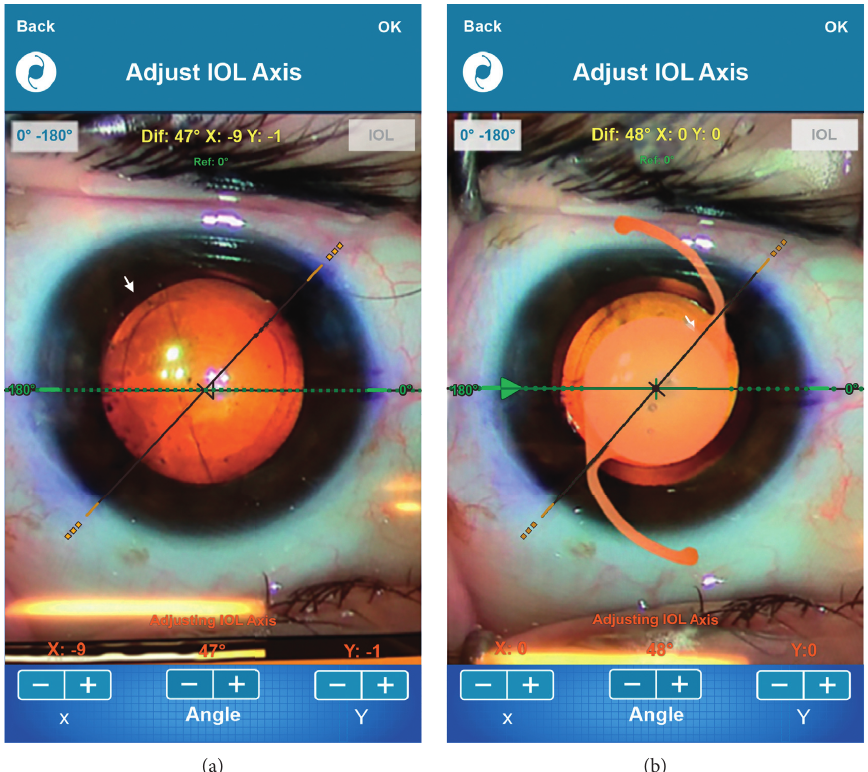
Figure 3: (a) Image from the video system coupled to the surgical microscope to adjust the IOL axis. (b) Overlay of the surgical planning images on the photo from the monitor adjusted to the IOL